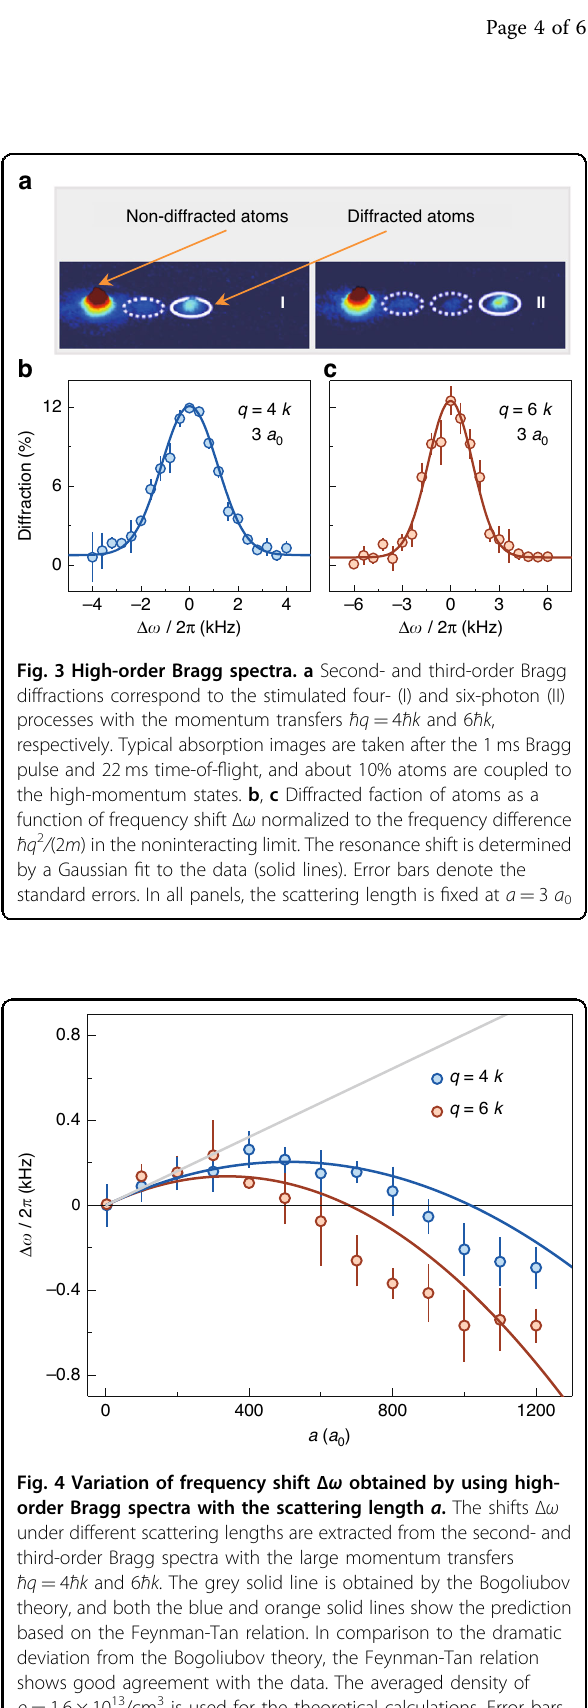
Fig. 4 Variation of frequency shift Δ ω obtained by using high- order Bragg spectra with the scattering length a . The shifts Δ ω under different scattering lengths are extracted from the second- and third-order Bragg spectra with the large momentum transfers ħ q = 4 ħ k and 6 ħ k . The grey solid line is obtained by the Bogoliubov theory, and both the blue and orange solid lines show the prediction based on the Feynman-Tan relation. In comparison to the dramatic deviation from the Bogoliubov theory, the Feynman-Tan relation shows good agreement with the data. The averaged density of ρ = 1.6 × 10 13 /cm 3 is used for the theoretical calculations. Error bars denote the fi tting